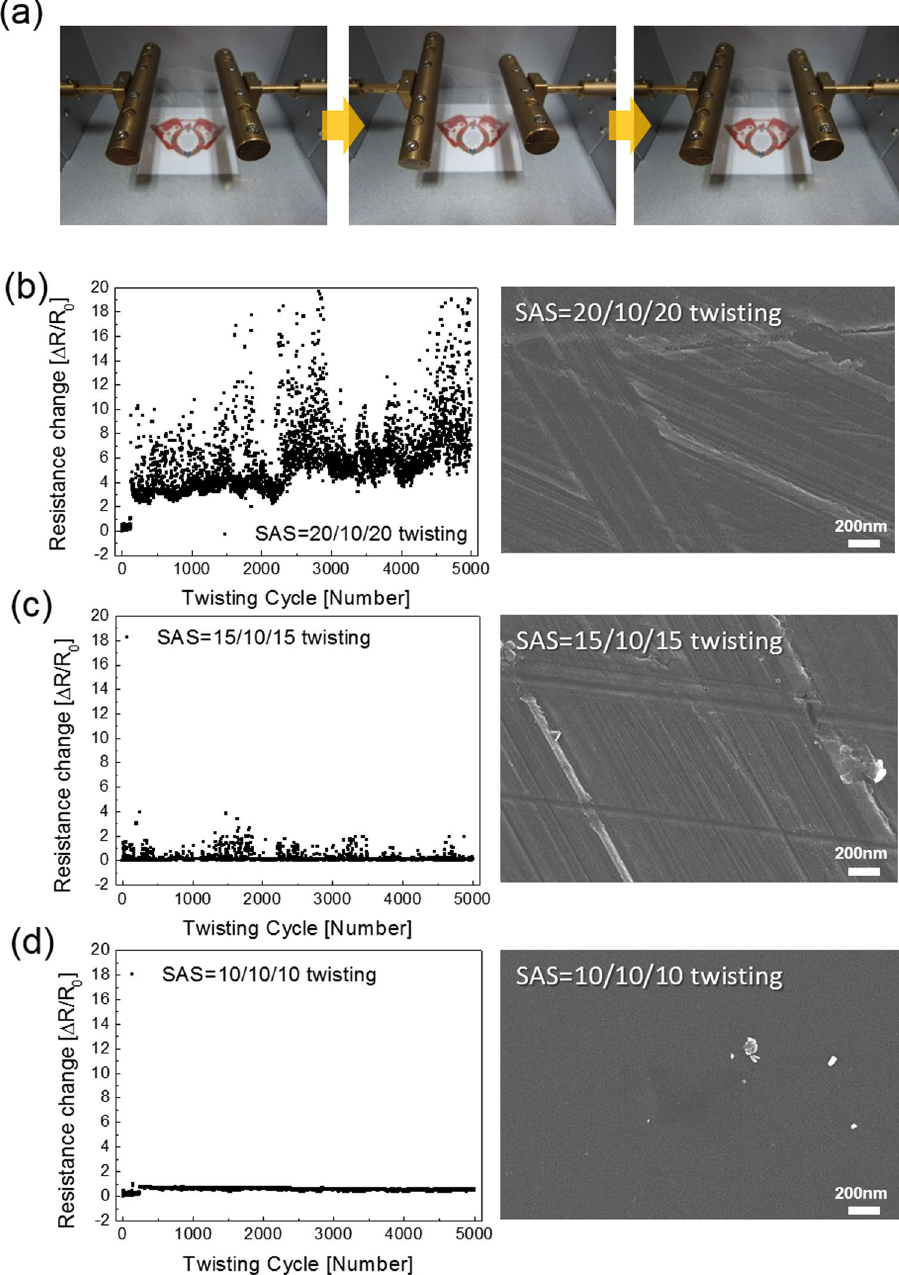
Figure 11. ( a ) Images of the twisting steps using a lab-designed twisting test system. The resistance change during the twisting test and surface FESEM images of the thermally evaporated SnO 2 /APC/SnO 2 multilayer with SnO 2 thickness of ( b ) 20 nm, ( c ) 15 nm, and ( d ) 10 nm